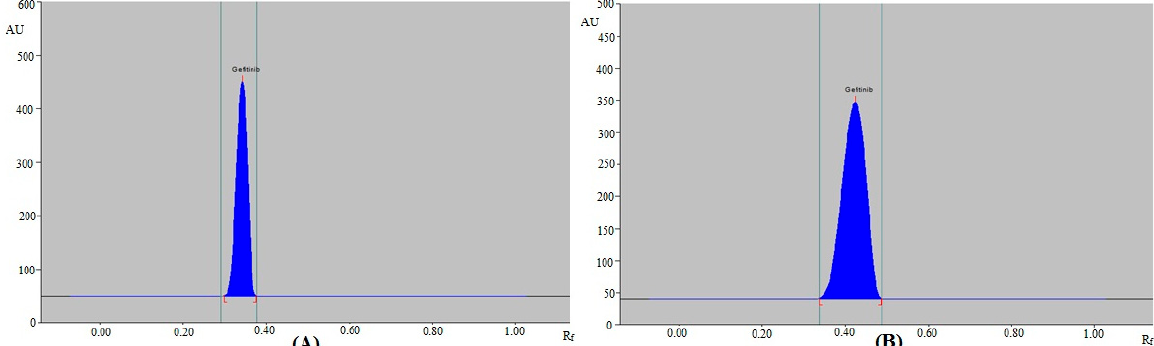
Figure 1. Representative “high-performance thin-layer chromatography (HPTLC)” densitograms of standard gefitinib (GFT) obtained using ( A ) routine HPTLC and ( B ) greener HPTLC methods.